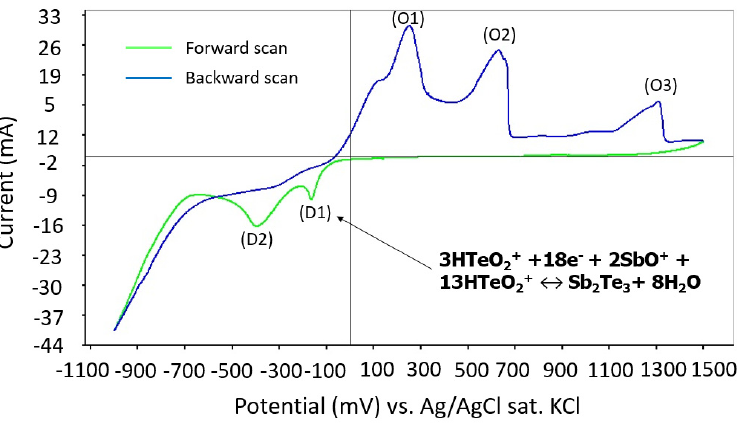
Figure 16. Cyclic voltammetry of SbTe deposition.